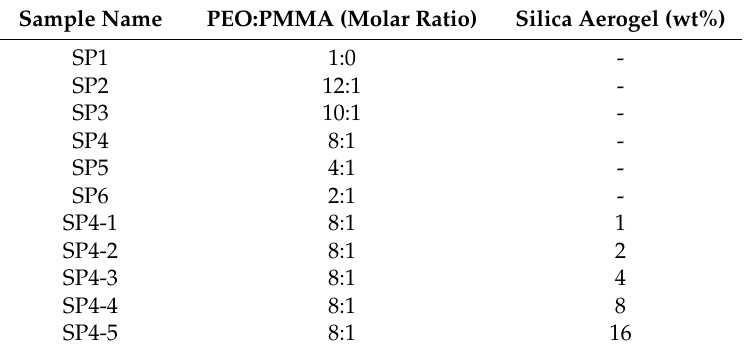
Table 1. Composition of the solid polymer